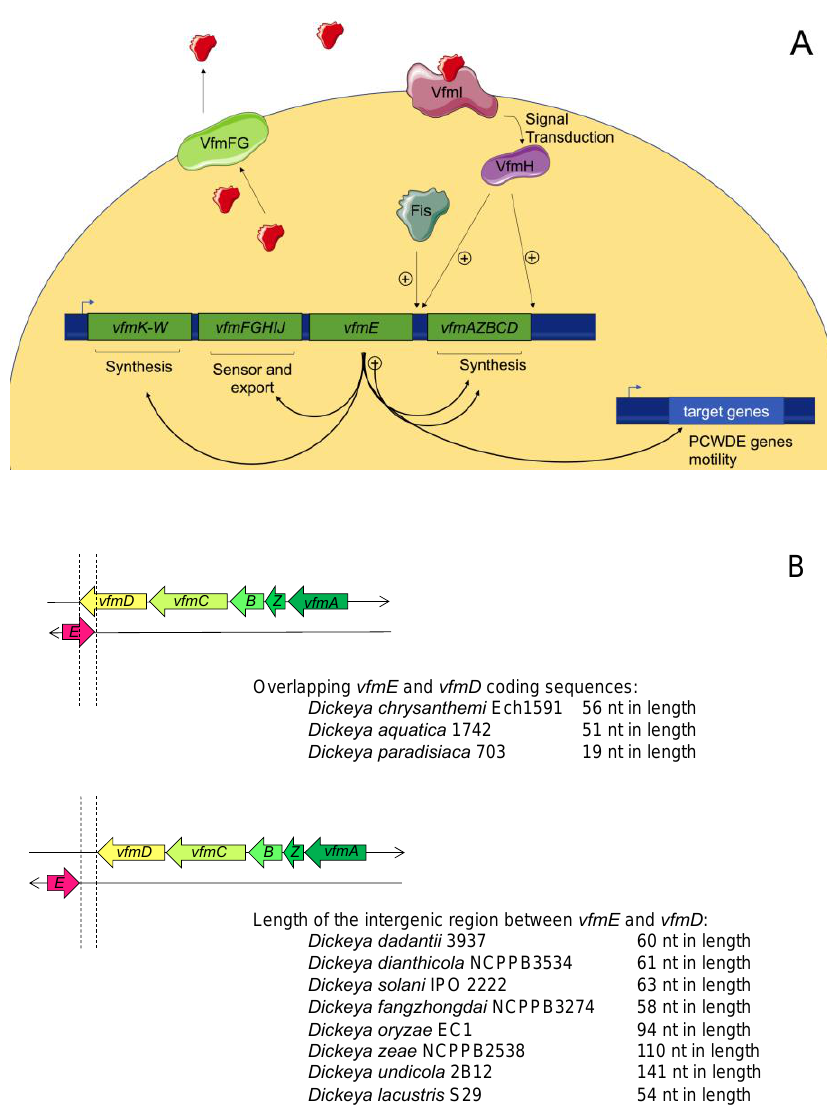
Figure 5. The VFM quorum-sensing (QS) system. ( A ) The vfm locus is composed of 26 genes. Genes vfmY-vfmK-W and vfmAZBCD encode proteins involved in the biosynthesis of the signal molecule, while vfmFG encodes an ABC transporter involved in the signal molecule export. VfmIH is a two- component system, where the sensor VfmI perceives the signal molecule (shown in red), and the regulator VfmH induces the expression of vfmE, which encodes a transcriptional activator of virulence factors and the vfm locus. In D. zeae, vfmE was shown to be regulated by Fis; ( B ) Genetic organization of vfmE and vfmAZBCD. In strains from D. chrysanthemi, D. aquatica, and D. paradisiaca, the coding sequences of vfmD and vfmE overlap. Genetic organization is different in D. poaceiphila.